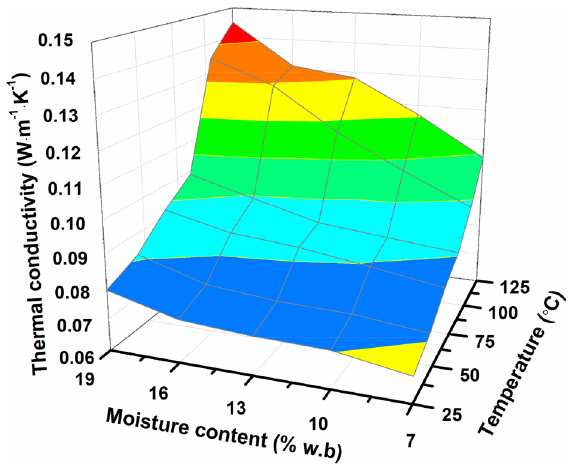
Figure 8. Thermal conductivity ( k ) of grinded Cassia tora L. seeds meal affected by moisture content.